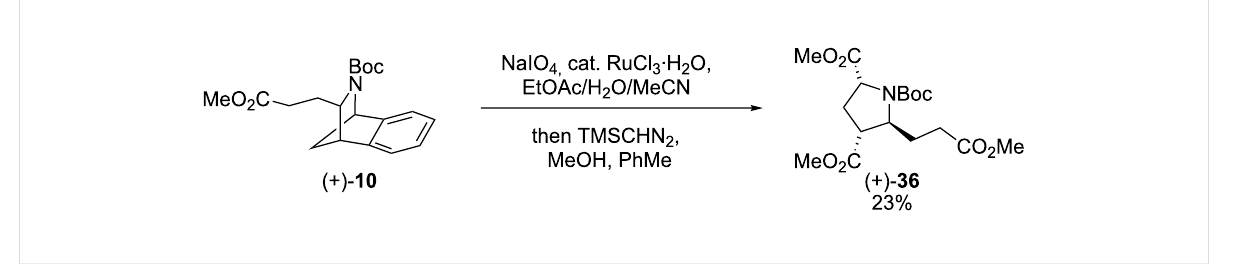
Scheme 8: Preparation of trisubstituted pyrrolidine (+)- 36